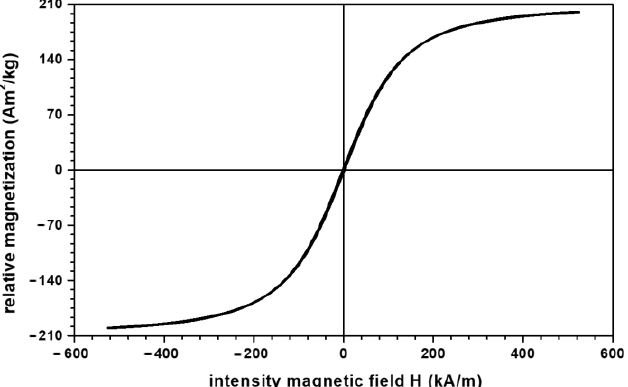
Figure 1. Magnetization slope of CI microparticles. (d) Silver microparticles (SmP), from Sigma-Aldrich (Saint Louis, MO, USA), product code 327085, with a minimum purity of 99.9%, average diameter 𝑑 SmP ≈ 3 μm, elec- trical resistivity of 59 × 10 −6 μΩ ∙ cm, and bulk density 𝜌 SmP = 1.336 g cm 3 ⁄ at a temperature of 20 °C.